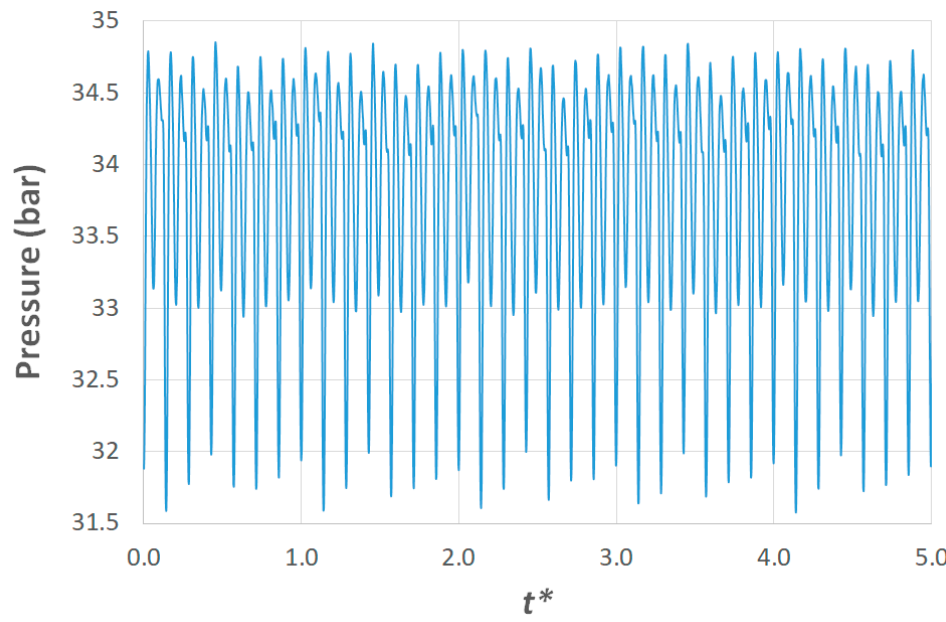
Figure 7. Pressure signal recorded at location P1 for BEP turbine prototype operation.